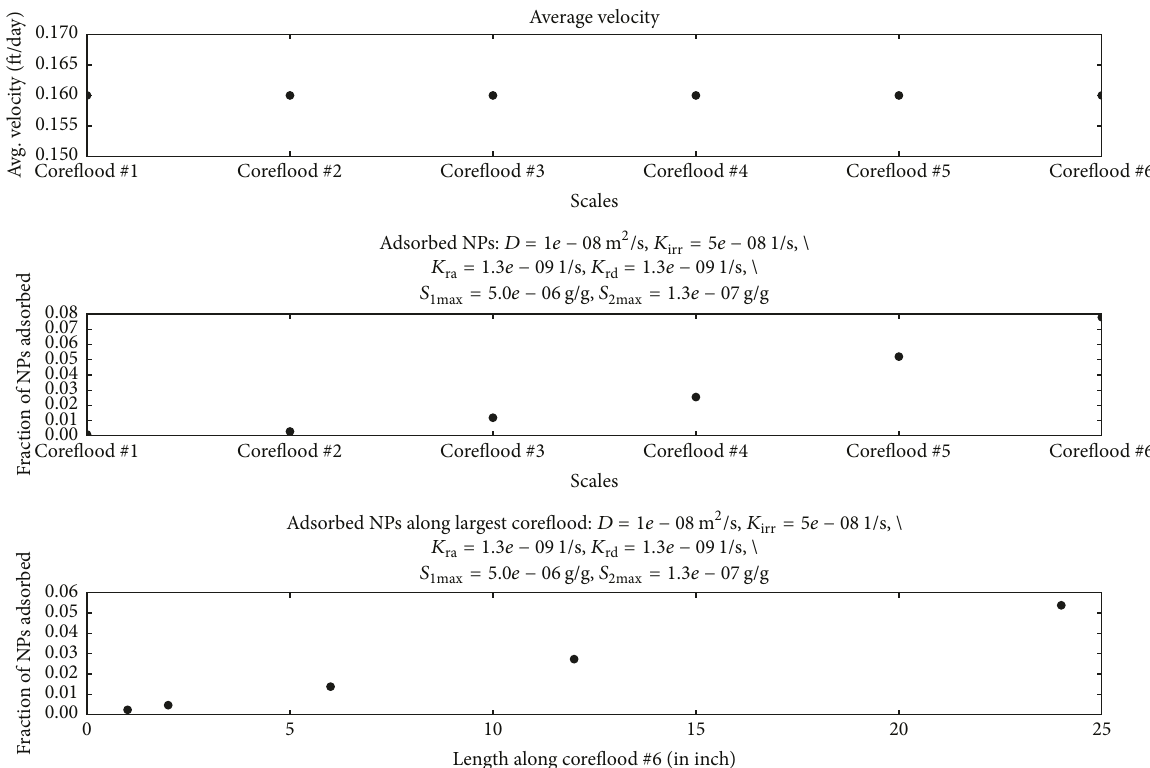
Figure 10: Fraction of NPs retained in six cores and at distances equal to smaller cores in the longest core. The results reported are for 4 pore volumes of injected NPs.